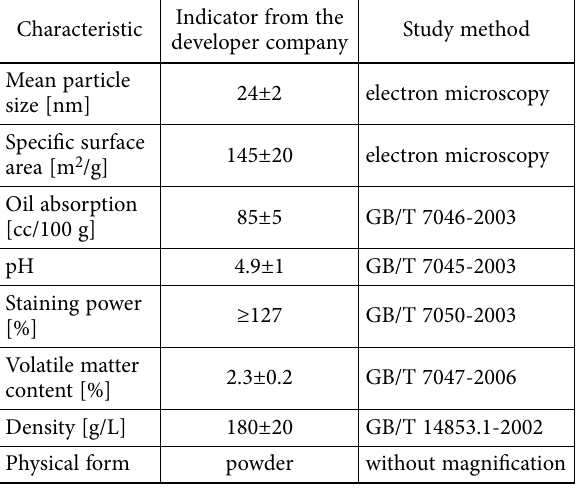
Table 1. Characteristics of nanodispersed soot carbon black of brand PowCarbon 2419G Characteristic